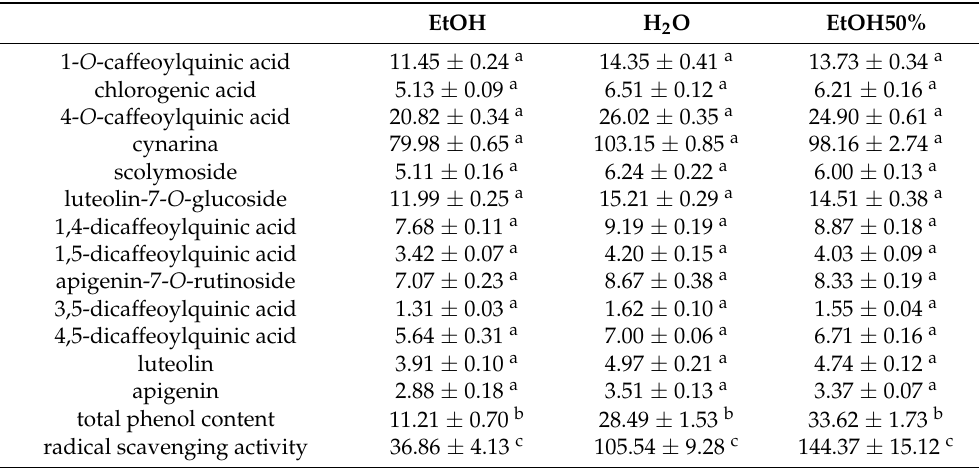
Figure 2. Total phenol content at different temperatures (60 °C, 80 °C, 100 °C, and 120 °C). Table 3. UPLC–UV quantitative analysis (280 and 325 nm) of different extracts (EtOH, H 2 O, and